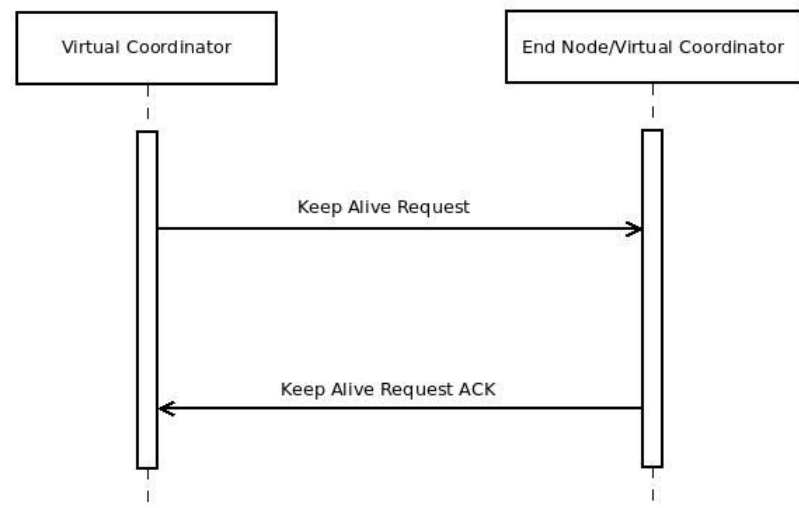
Figure 8. Message flow in a successful control check or keep alive operation.